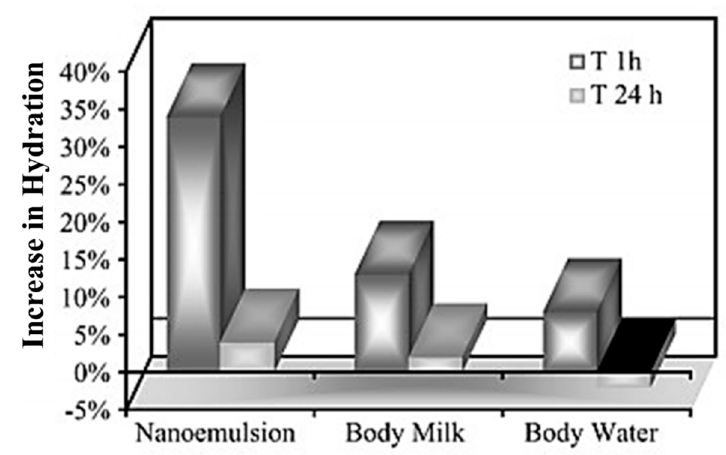
Figure 7. Increase in hydration of the fore-arm stratum corneum 1 h and 24 h after treatment with different products. Reproduced with permission from Sonneville et al., Advances in Colloid & Interface Science, Published by Elsevier, 2004 [128].